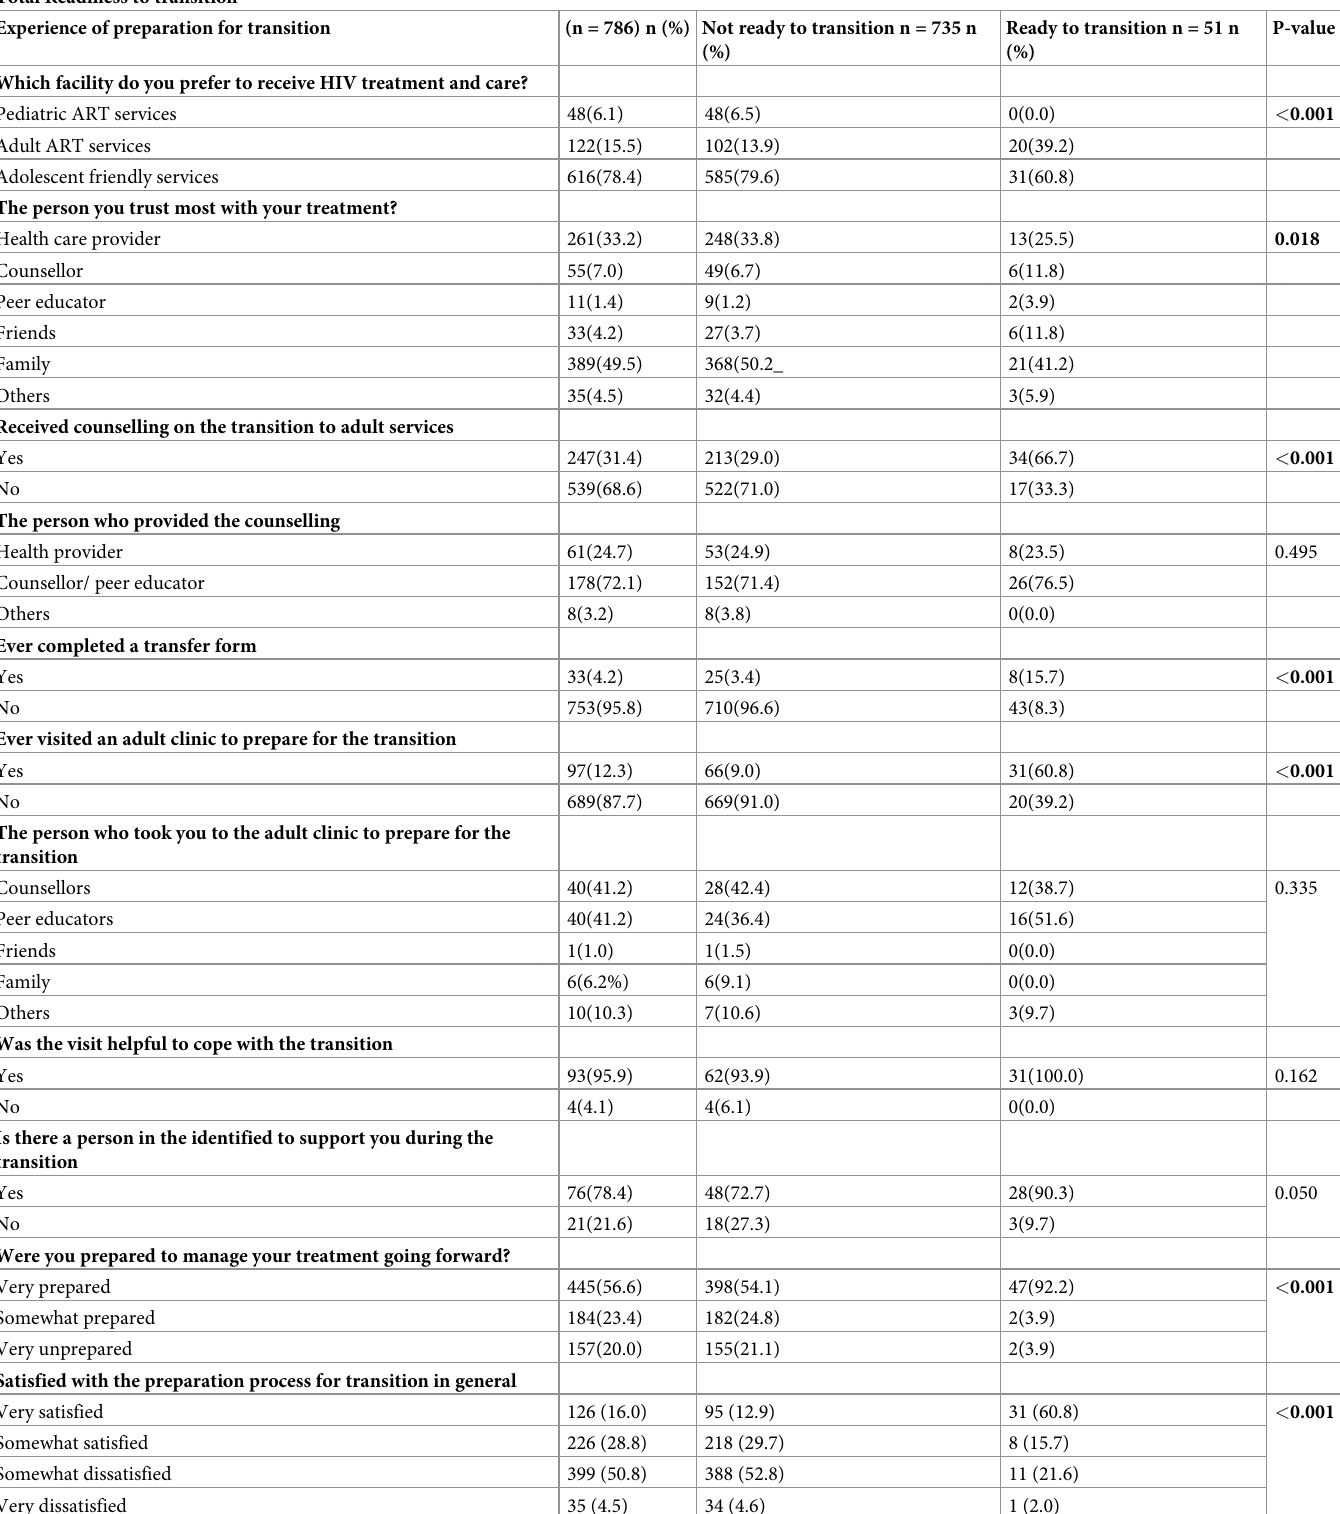
Table 4. Experience of preparation for the transition of adolescents to adult ART care and transition